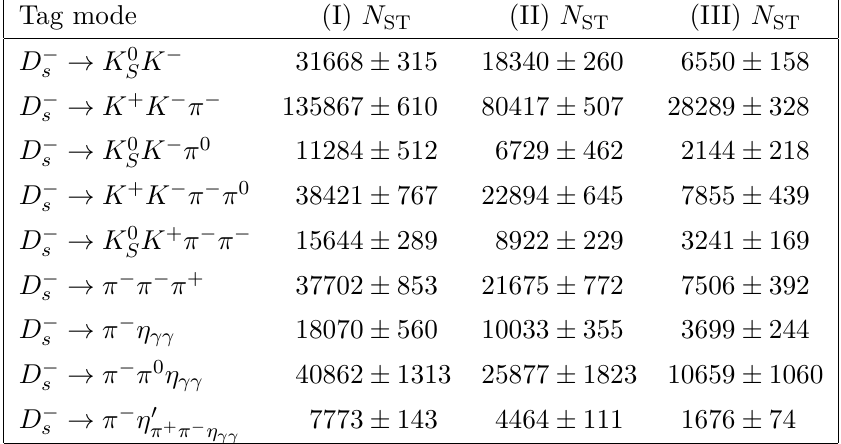
Table 7 . The ST yields for the samples collected at (III) 4.226 GeV. The uncertainties are